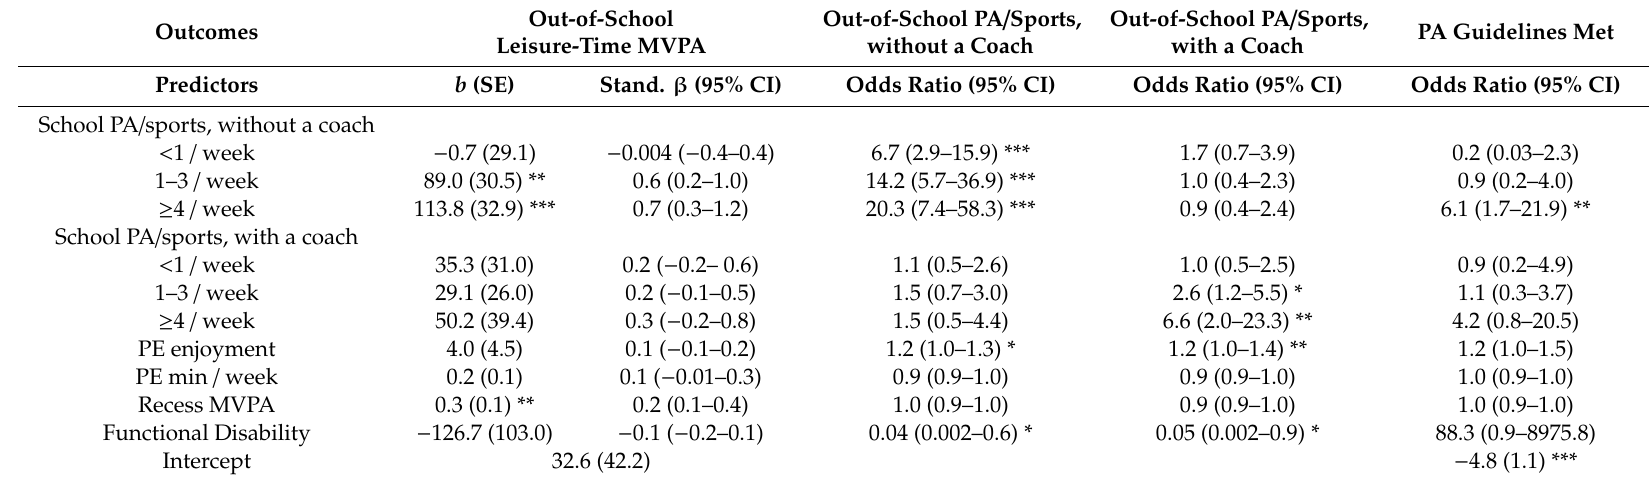
Table 4. In-school physical activity as a predictor of out-of-school physical activity and meeting the physical activity